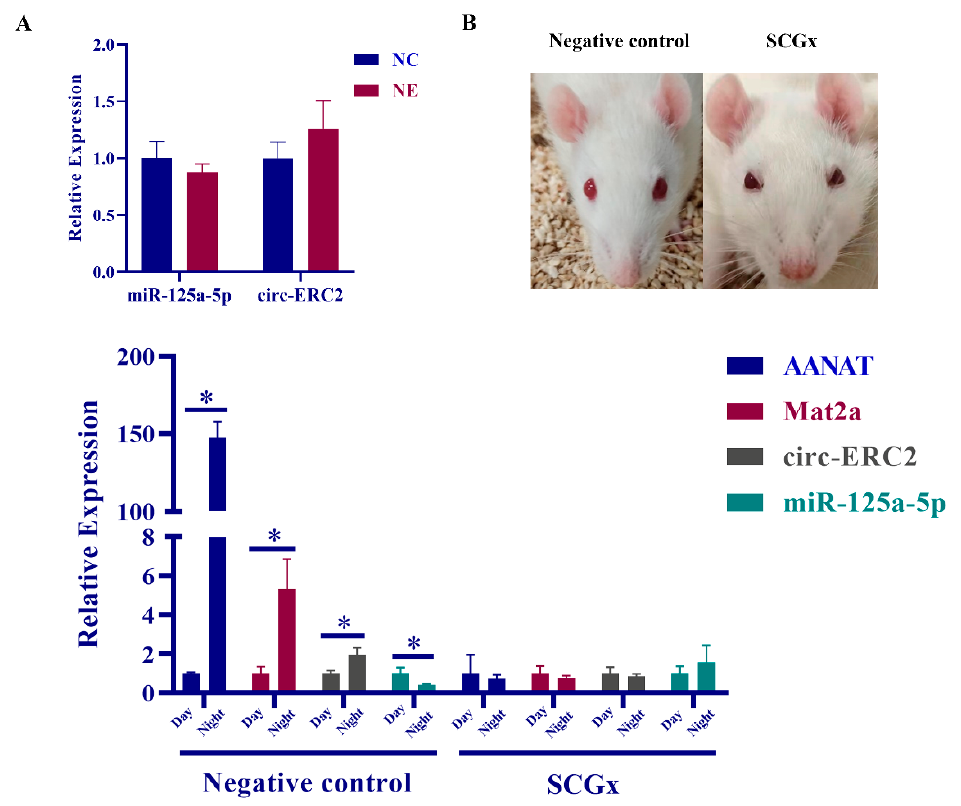
Figure 6. Superior cervical ganglion (SCG) can participate in melatonin synthesis through circ- ERC2/miR-125a-5p/MAT2A axis. ( A ) Relative expression of miR-125a-5p and circ-ERC2 in pineal cells before and after NE treatment. ( B ) Relative expression of genes in the pineal gland of control and SCGx groups during the day and night. *, p < 0.05.